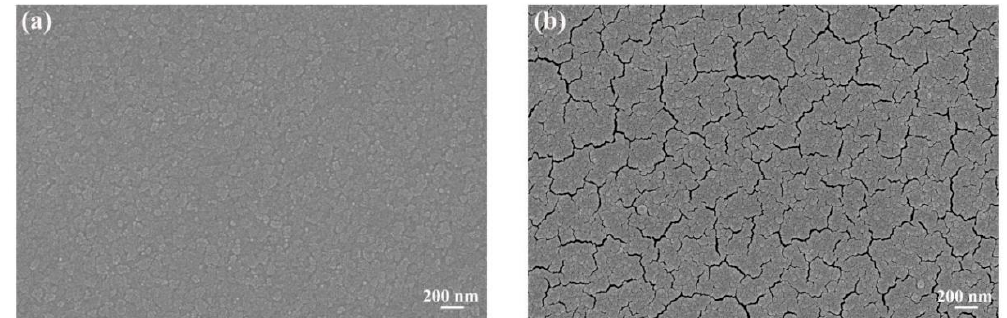
Figure 4. SEM images of the WO 3 films. ( a ) nanostructured WO 3 film, ( b ) ordinary WO 3 film.